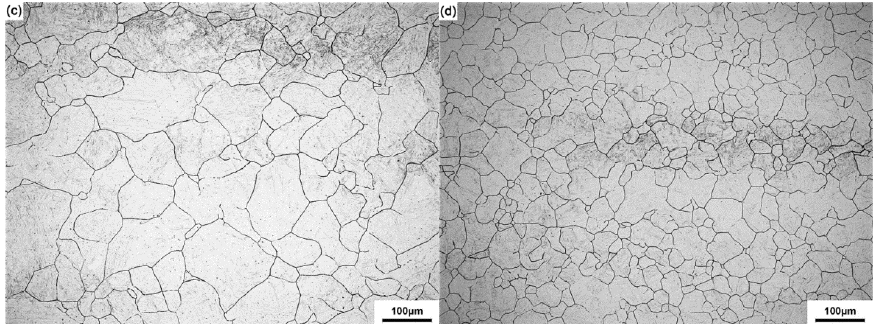
Figure 10. The microstructure of the deformed 30Cr2Ni4MoV steel to a strain of 0.7 at: ( a ) 1000 °C/0.1 s − 1 ;